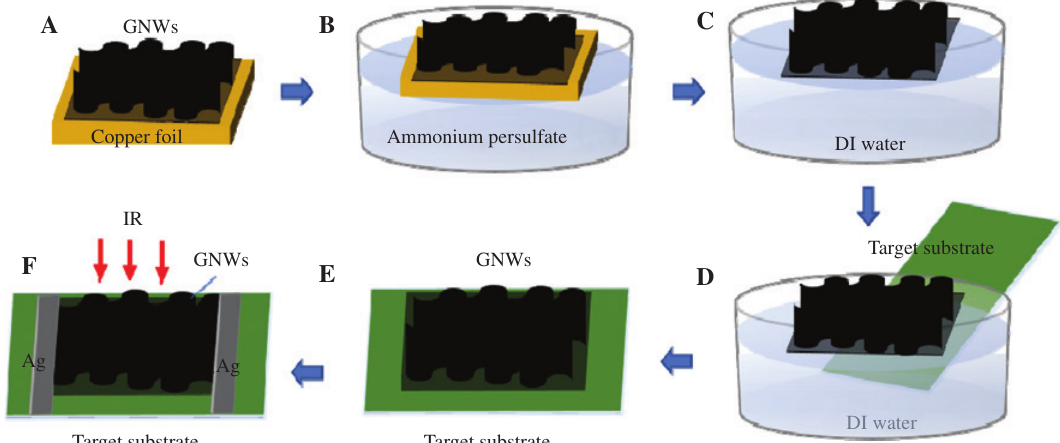
Figure 1: Schematic diagram of device